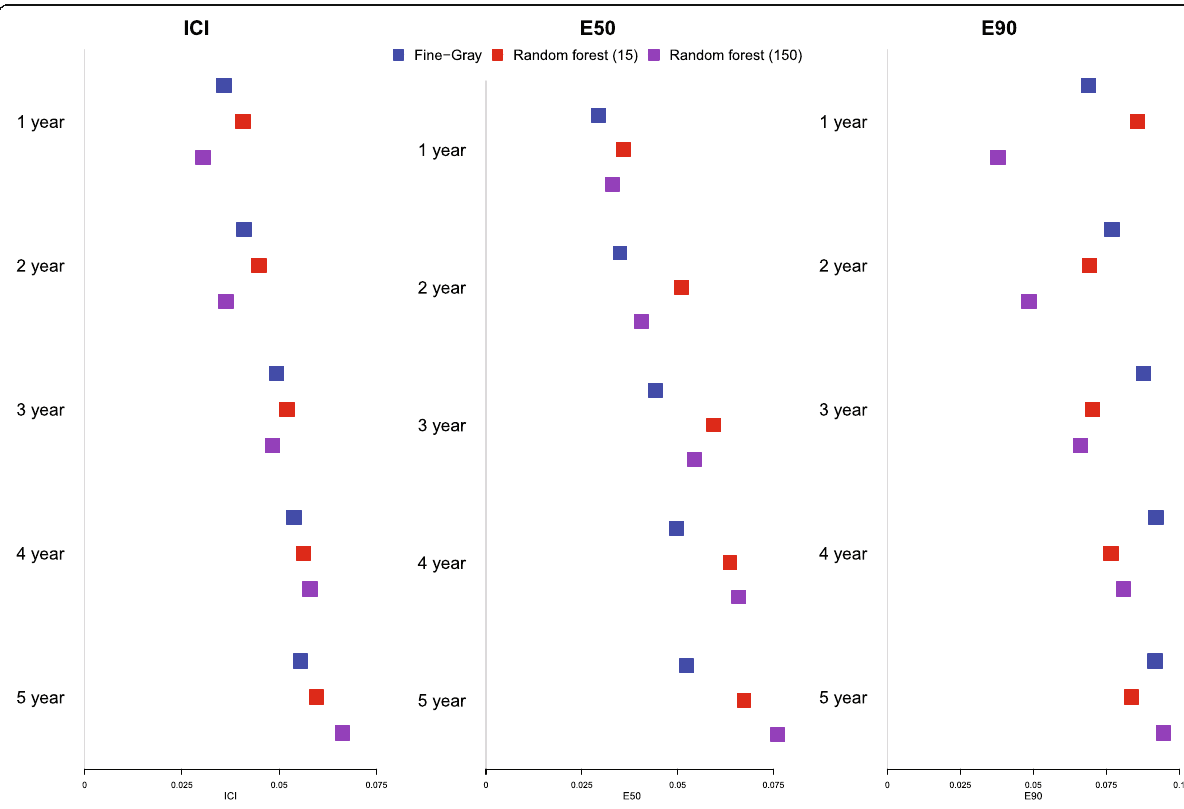
Fig. 14 ICI/E50/E90 in case study validation sample (predicting cardiovascular